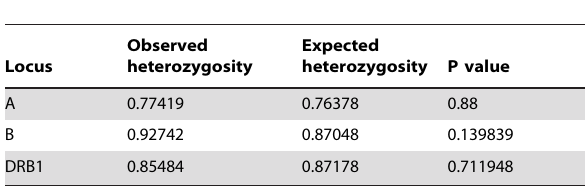
Table 1. Observed and expected heterozygosity and